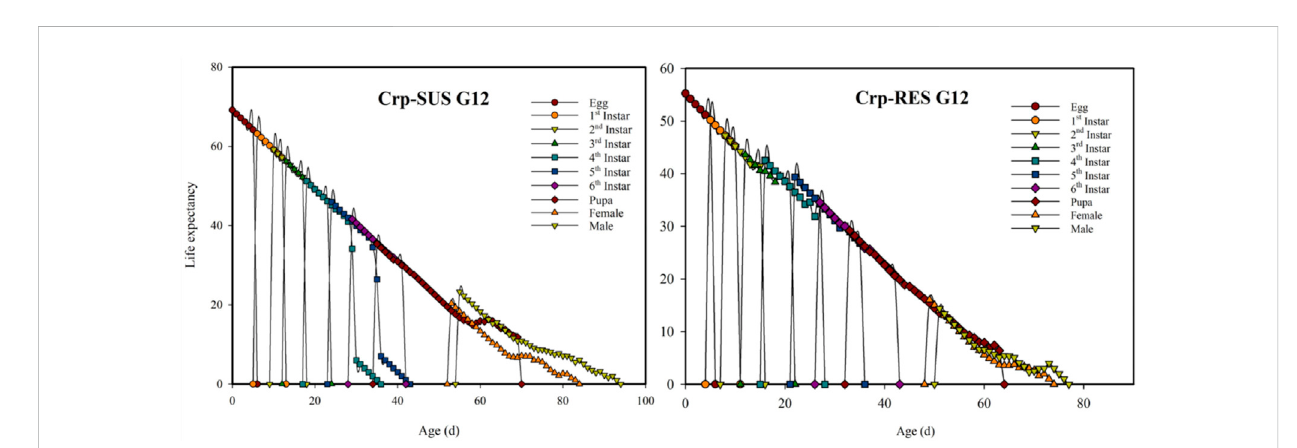
FIGURE 3 Age-stage-speci fi c life expectancies ( e xj ) for the Crp-RES G 12 and Crp-SUS G 12 strains of S. frugiperda